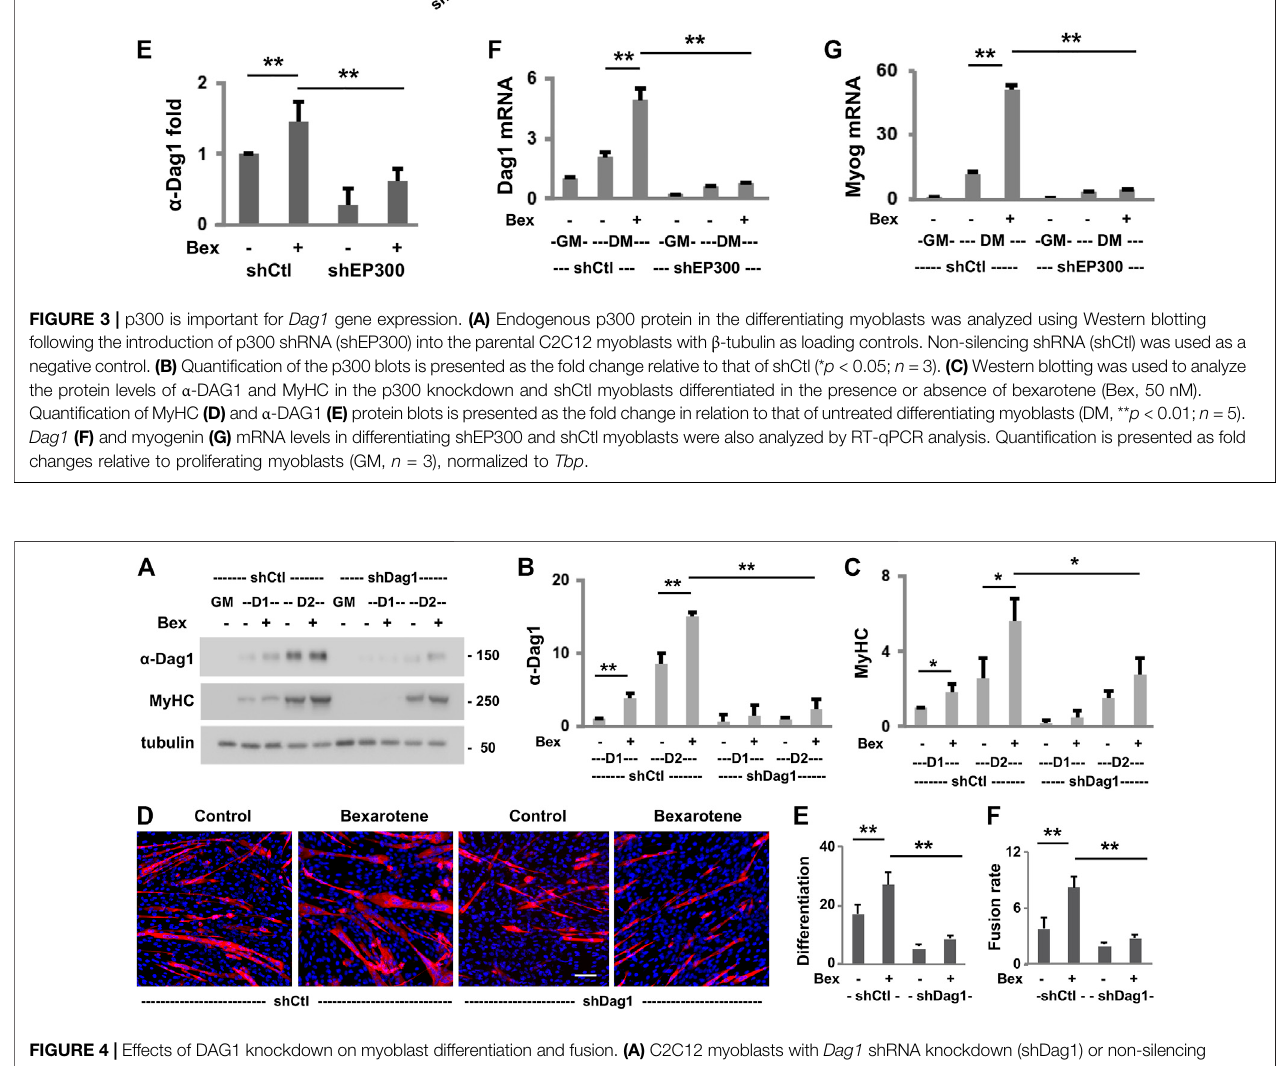
FIGURE 4 | Effects of DAG1 knockdown on myoblast differentiation and fusion. (A) C2C12 myoblasts with Dag1 shRNA knockdown (shDag1) or non-silencing shRNA(shCtl)weredifferentiatedfor1or2 daysinthepresenceorabsenceofbexarotene(Bex,50 nM)andsubjectedforWesternblotting.Proliferatingmyoblastswere used as controls (GM). MyHC is included as a myogenic differentiation marker and β -tubulin as a loading control. Quanti fi cation of the protein levels of DAG1 (B) and MyHC (C) is presented as fold change in relation to that of untreated differentiating myoblasts (* p < 0.05; ** p < 0.01; n = 3). (D) shDag1 knockdown and control myoblasts were differentiated for 4 days with or without bexarotene. The representative images (scale bar: 100 μ M) stained with MyHC (red) and nuclei (blue). (E) Differentiation was de fi ned as the percentage of myogenic nuclei relative to the total number of cell nuclei ( n = 4). (F) Fusion rate was de fi ned as the average number of nuclei per MyHC positive